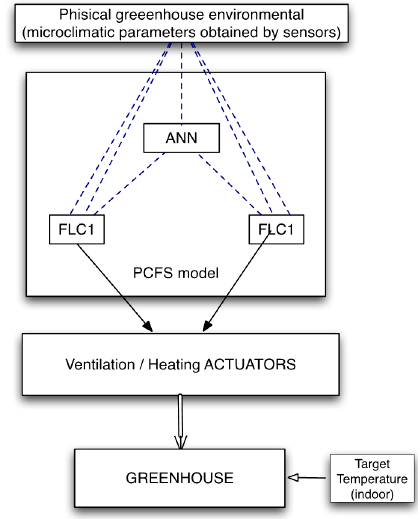
Figure 1. PFCS System Model. ANN: artificial neural network; and FLC: fuzzy logic controller.